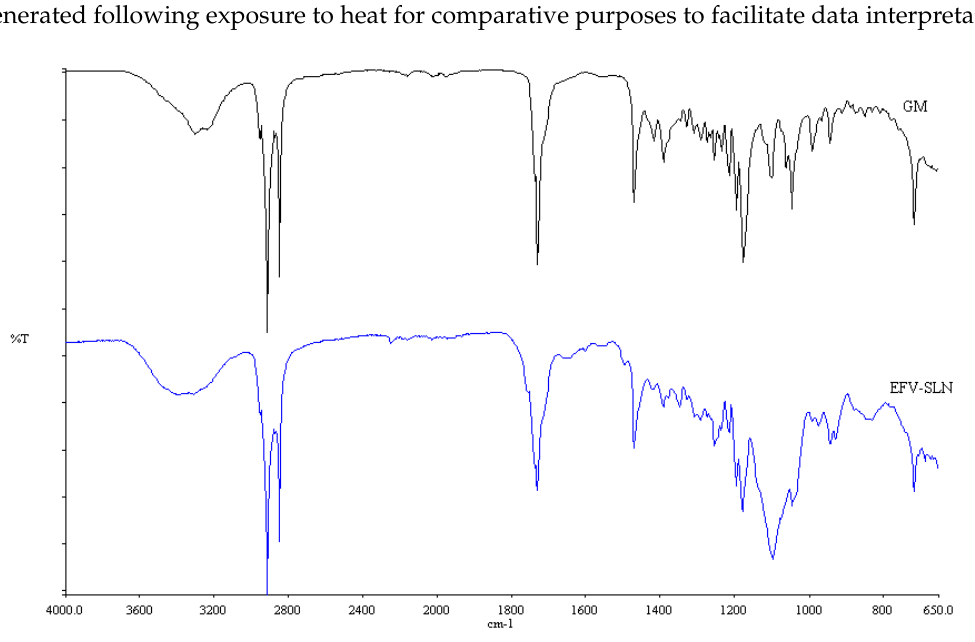
Figure 10. FT-IR spectra of optimized EFV-loaded SLN and GM following exposure to heat.